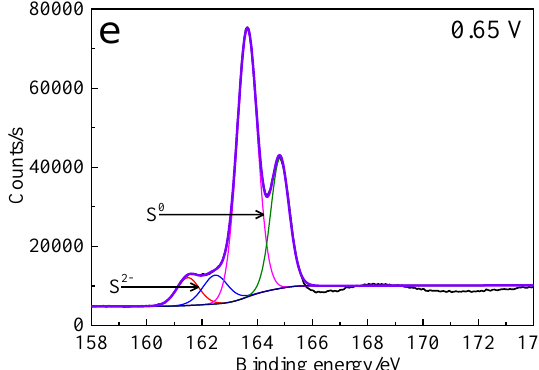
Figure 13. XPS spectra of S 2p peaks of bornite surface after treating by different potential of 0, 0.3, 0.45, 0.55, 0.65 V, respectively: ( a ) Untreated; ( b ) 0.3 V; ( c ) 0.45 V; ( d ) 0.55 V; ( e ) 0.65V (Implemented on the model of ESCALAB 250Xi of Al Kα X-ray source with 20 eV constant pass energy and 0.1 eV/step; Fitted by Thermo Avantage 5.52, C 1s 284.8 eV as reference, Shirley method, Gaussian- Lorentzian function).